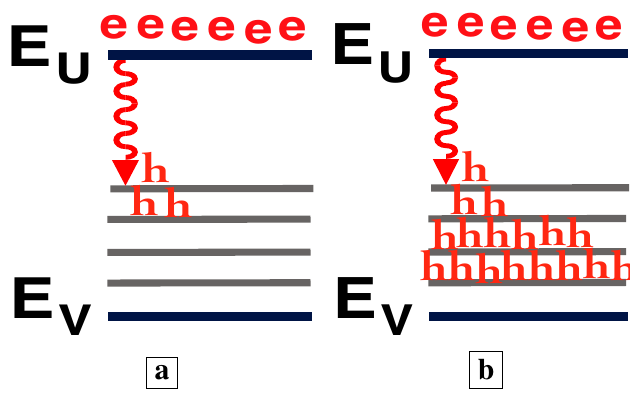
Figure 21 . Electron and hole population distribution in Sample F (no resonant cavity). a, At small injection, holes occupy mainly midgap states. b, At higher current injection, band filling occurs. In the absence of a resonant cavity, the number of holes in deep-levels increases with increasing injection, as seen in Figure 13.